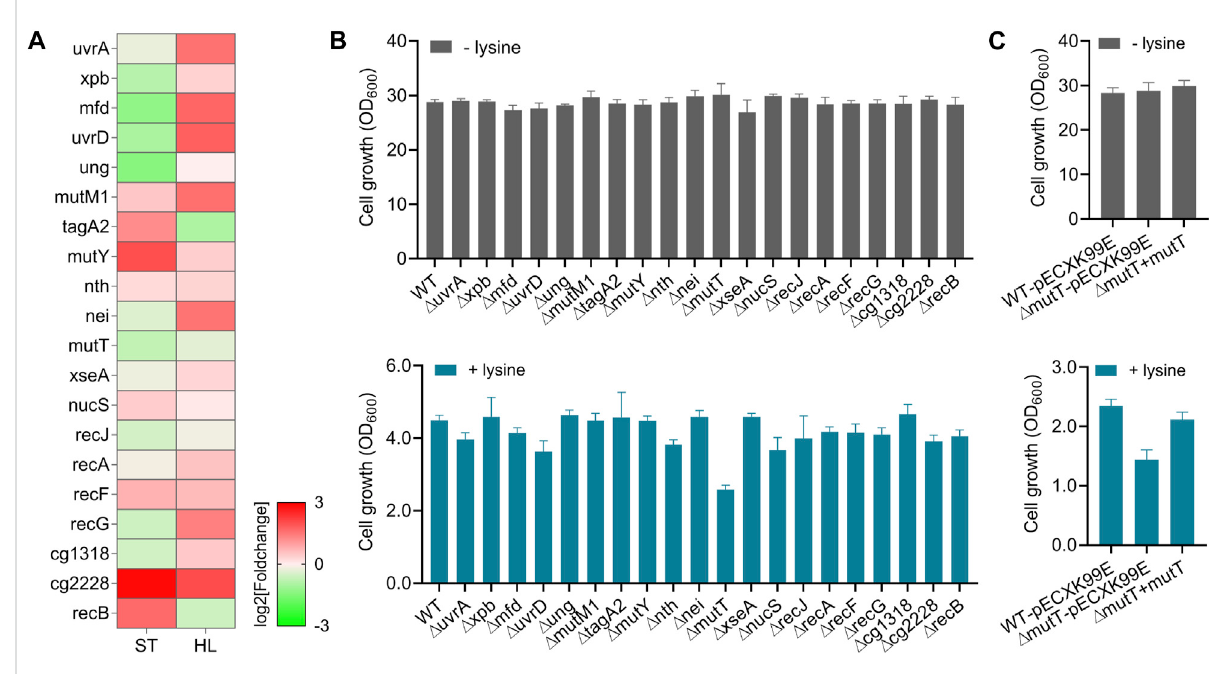
FIGURE 5 Roles of DNA repair systems in protecting cells against high-lysine-induced osmotic stress. (A) Expression pro fi les of representative genes implicated in DNA repair mechanisms among ST and HL samples. (B) Growth assays of the wild-type and DNA repair-defective mutants with and without lysine treatment. After overnight pregrowth at 32 ° C, the cells were, respectively, shifted to CGXII medium with an initial OD 600 of 0.1 and incubatedforanother20 hwithshaking.Then,160 g/Llysinewasusedtomimicosmoticstress. (C) Growthassaysofthewild-type, Δ mutT, and complemented strains in response to the challenge of 160 g/L lysine. The shuttle vector pECXK-99E was used for the expression of mutT gene in C. glutamicum